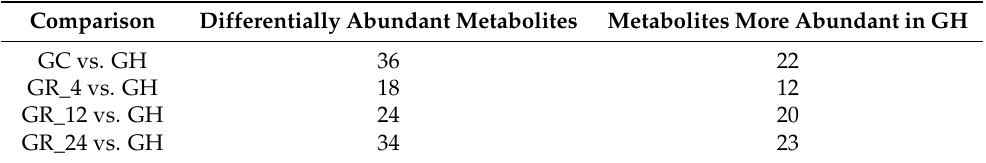
Figure 2. The partial least squares discriminant analysis (PLS-DA) plots of the metabolomic data. ( A ) Groups GH and GC, ( B ) groups GH and GR_4, ( C ) groups GH and GR_12; ( D ) groups GH and GR_24. Each point represents one replicate pooled gill sample. Table 1. Differentially abundant metabolites between groups. Comparison Differentially Abundant